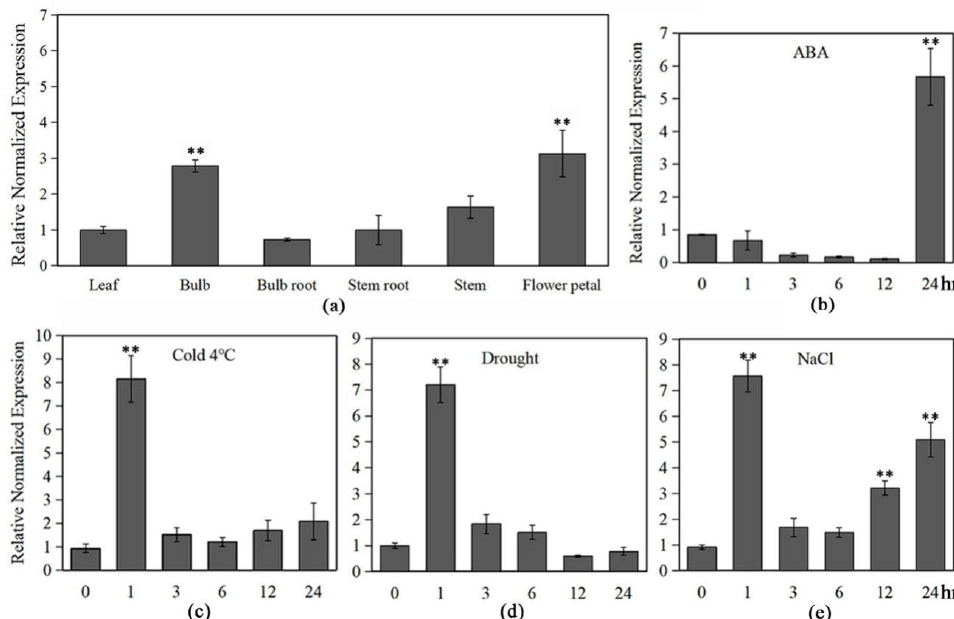
Figure 2. Expression patterns of LlMYB3 in tiger lily seedlings under di ff erent stress treatments. Expression patterns of LlMYB3 in leaves, bulbs, roots, stems, and flower petal ( a ), and after ABA ( b ), cold ( c ), drought ( d ) and NaCl ( e ) treatments in leaves by qRT-PCR analysis. Transcript levels were normalized to LlTIP1 . Values are means ± SD of three replicates. Three independent experiments were performed. Asterisks indicate a significant di ff erence (** p < 0.01) compared with the corresponding controls.